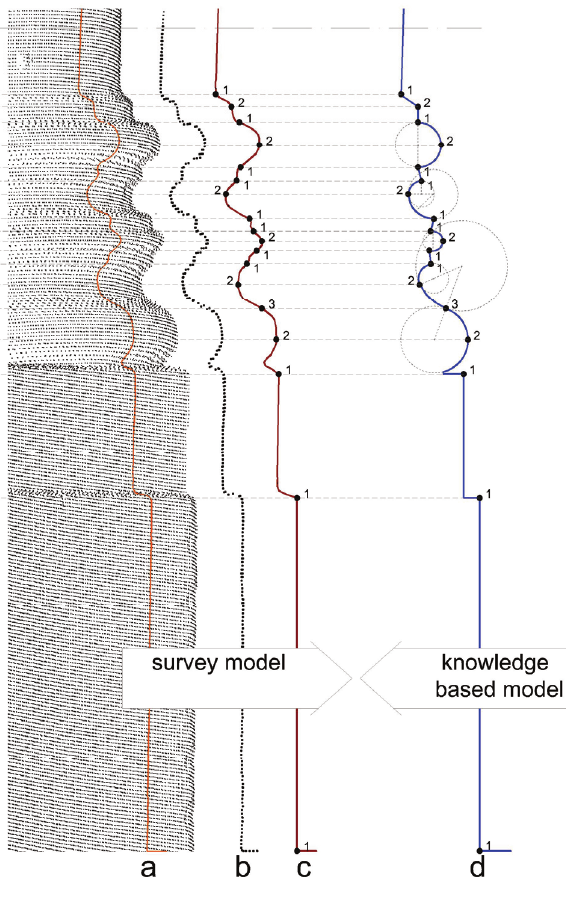
Figure 9. The San Carlo column base. Comparison between sections of survey model and knowledge based model a) marked points at a fixed distance from the plane of section; b) selected points from a) c) elaborated polyline with relevant nodes: 1 (angular points), 2 (maximum overhang points), 3 (inflexion points) d) knowledge based section with the same relevant nodes